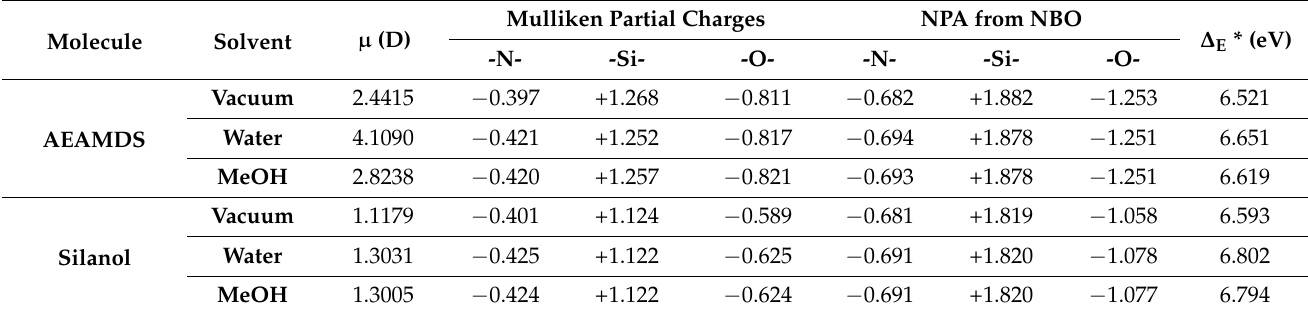
Table 4. Calculated data for target molecules (with N in the β